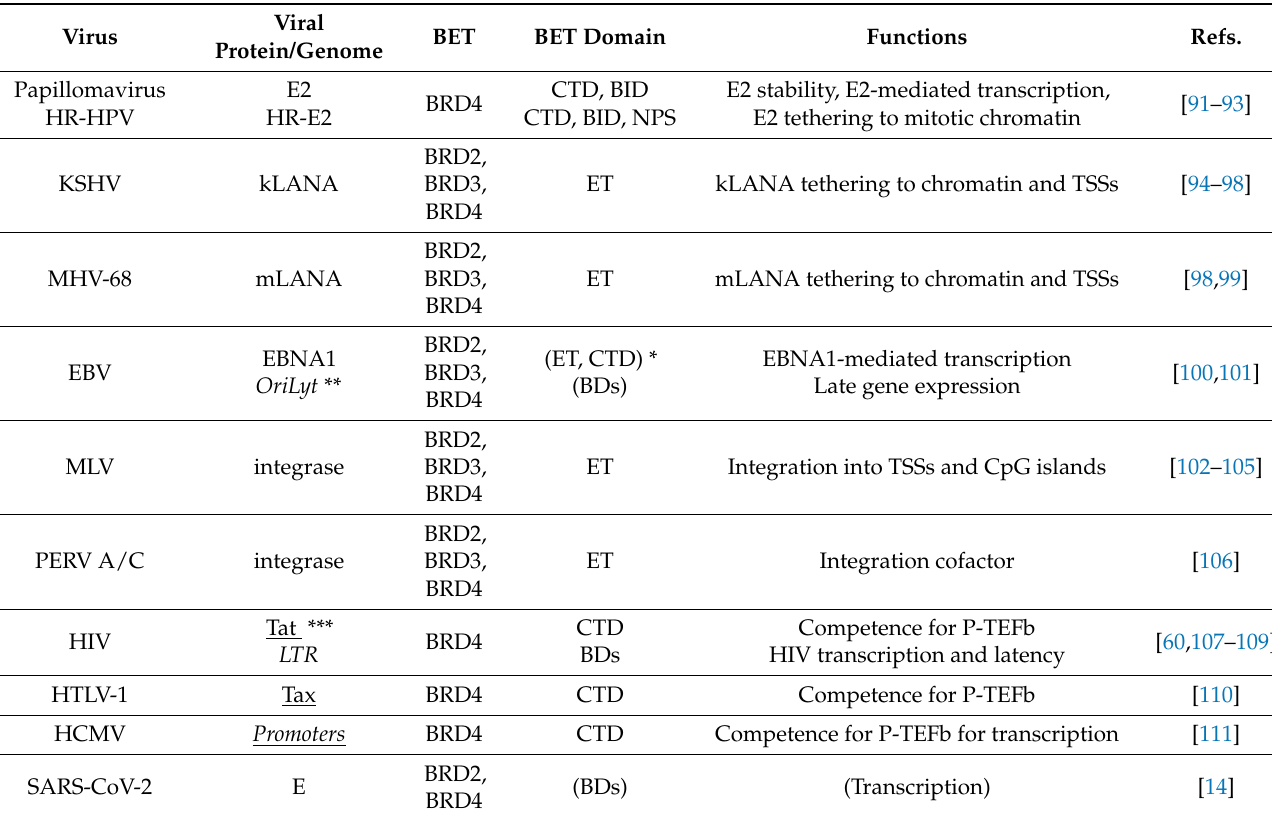
Table 1. BET interactions with